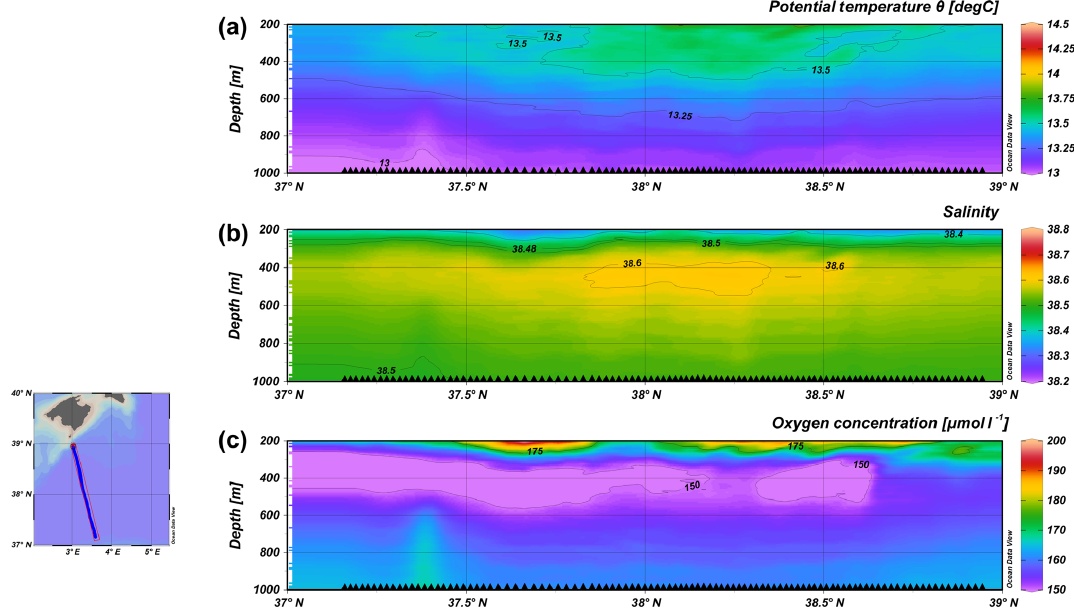
Figure 9. Intermediate and deep layer (200–975m depth) along-track sections of potential temperature (a) , salinity (b) and oxygen concen- tration (c) obtained from ABACUS 3 glider data. Black triangles indicate the position of the single glider